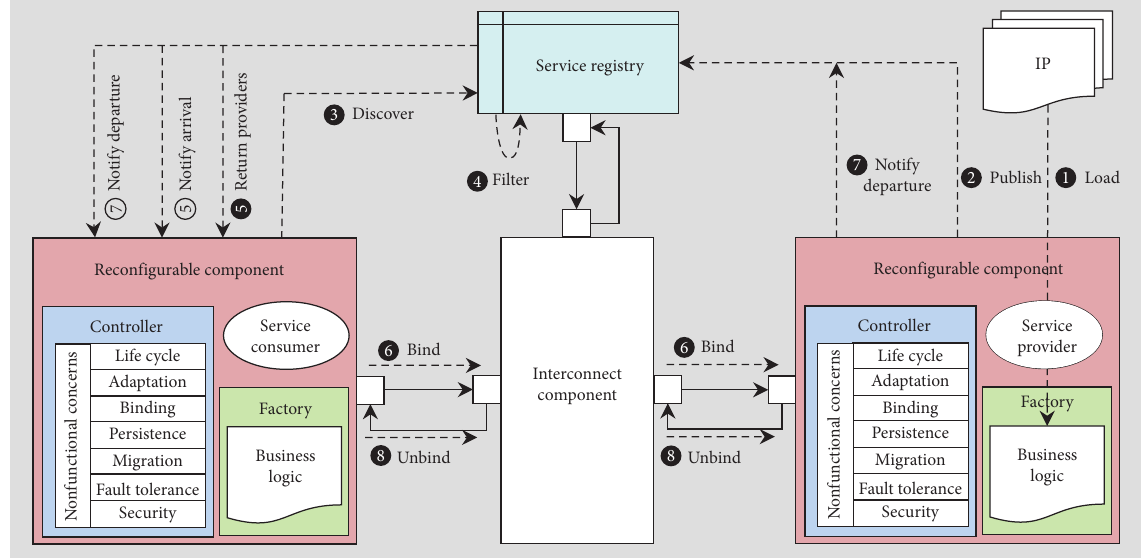
Figure 1: SOCM interaction pattern.